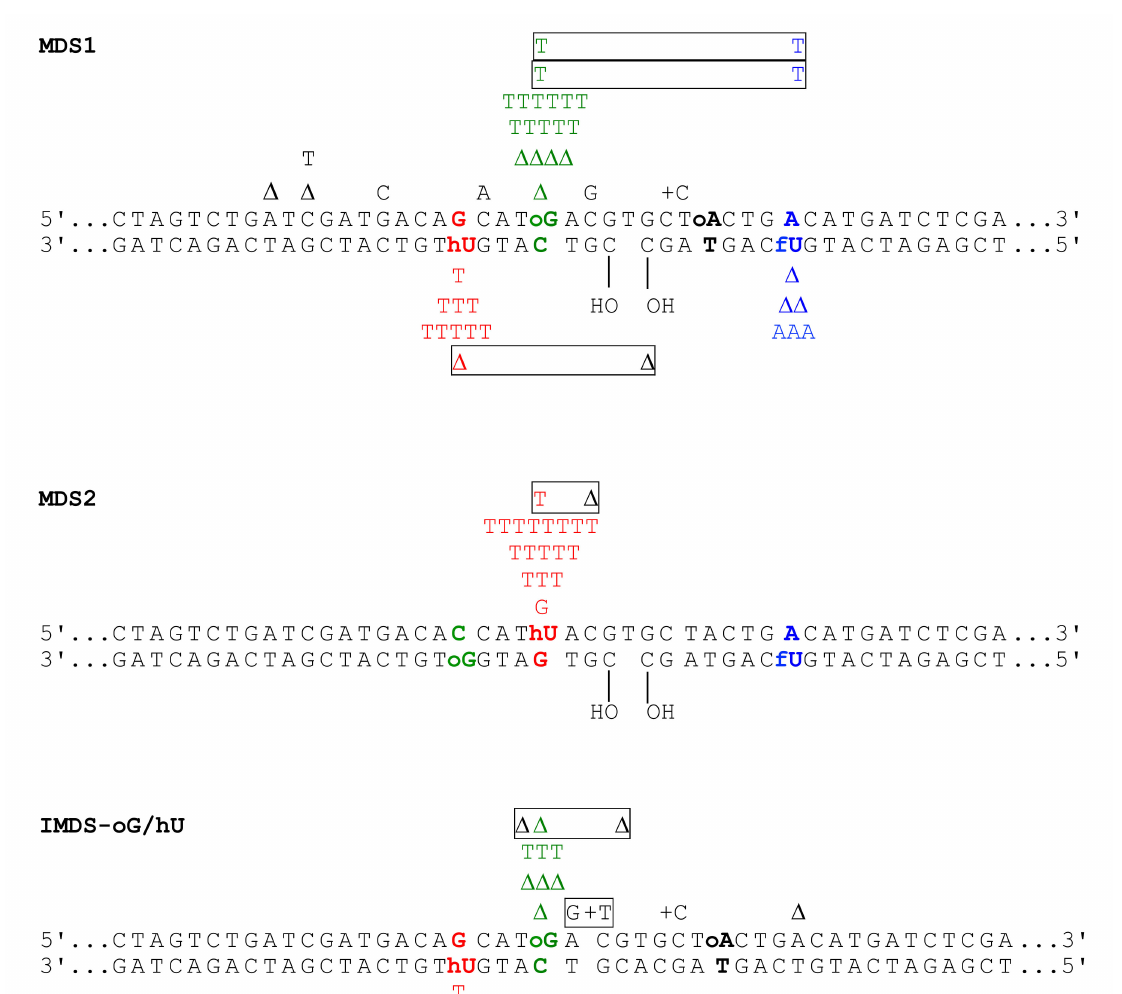
Figure 2. Mutation spectra induced at complex MDS in the WT yeast strain. Positions of the lesions and targeted mutations are bolded and color marked. Red indicates the hU • G pair, green indicates the oG • C pair, black indicates the oA • T pair, and blue indicates the fU • A pair. Mutations in black are untargeted. Double mutations are boxed. Frequencies of non-targeted mutations in IMDS-oG/hU, MDS1, and MDS2 are 10%, 9.5%, and 4%,